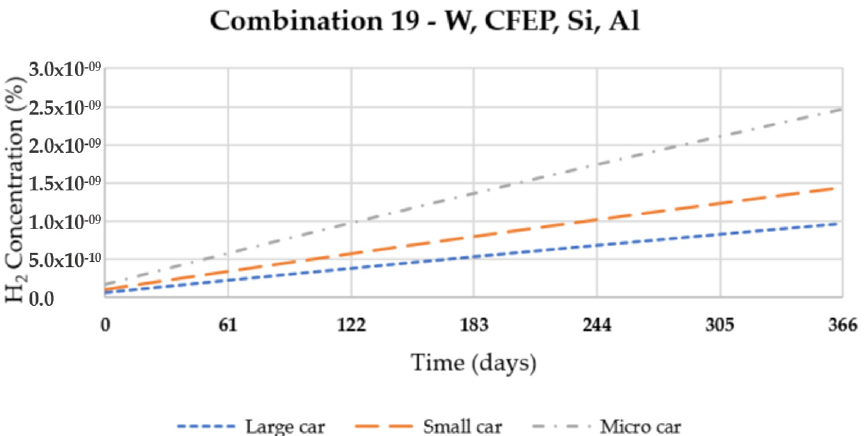
Figure 8. H 2 concentration in the garage, combination 19 from Table 3.